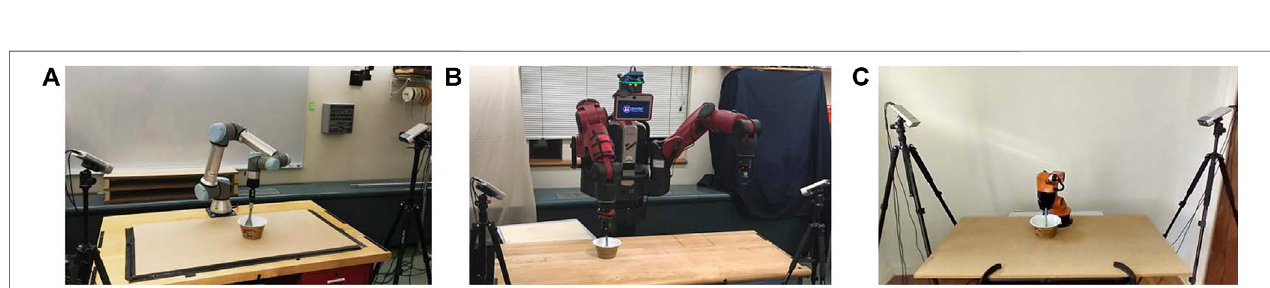
FIGURE 5 | Workspaces. The workspace of (A) UR5e, (B) Baxter, and (C) the Kuka youBot robot are similar. Two Azure Kinect RGB-D sensors are placed on the sides of the workspace.